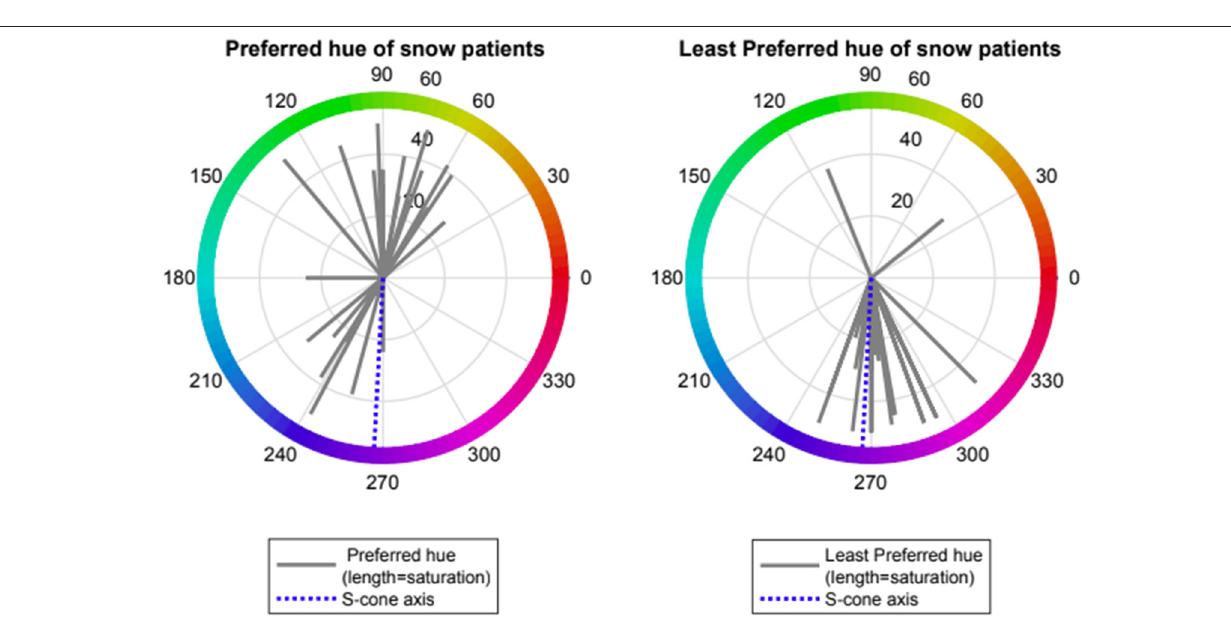
entoptic phenomena and 64% photophobia and nyctalopia. Associated non-visual symptoms included 86% tinnitus, 59% migraine, and 46%